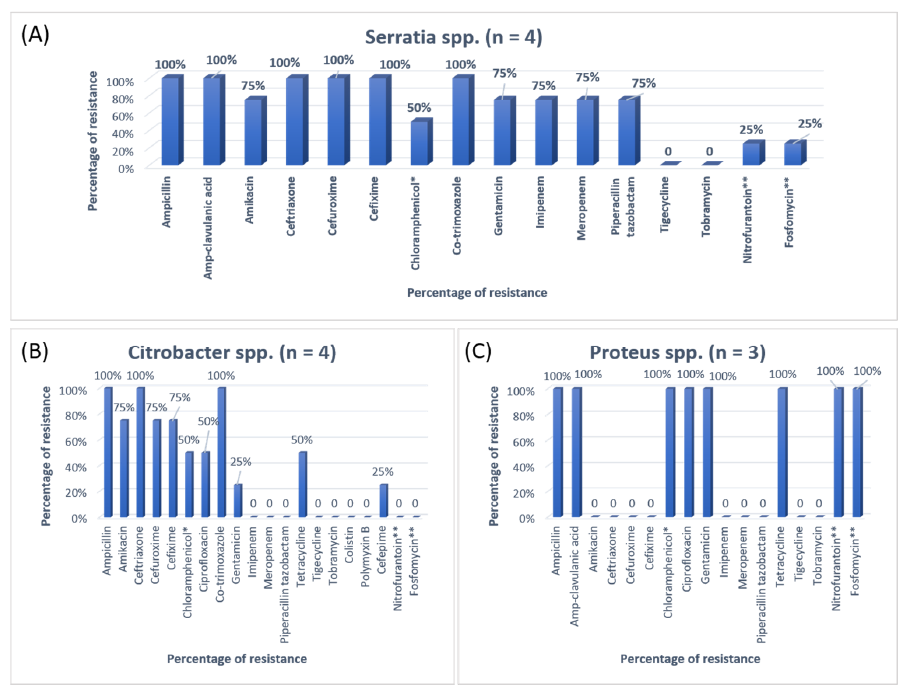
Figure 3. The antibiotic resistance patterns in ( A ) Serratia spp., ( B ) Citrobacter spp., ( C ) Proteus spp. * Not reported in urinary isolates. ** Only reported in urinary